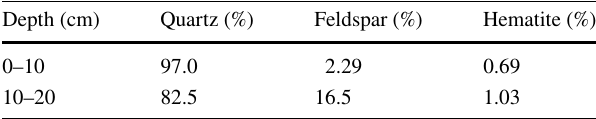
Table 1 Main mineral components of Dystric Xeropsamments with long-term organic